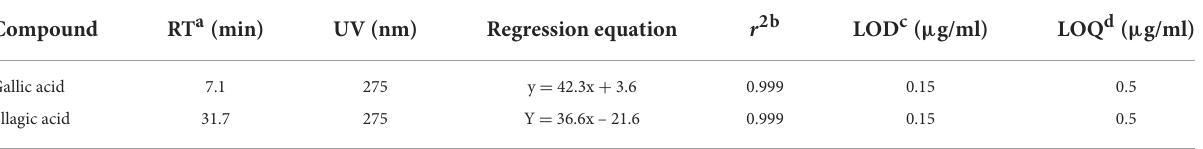
TABLE 1 Regression equation with the LODs and LOQs of gallic acid and ellagic acid.